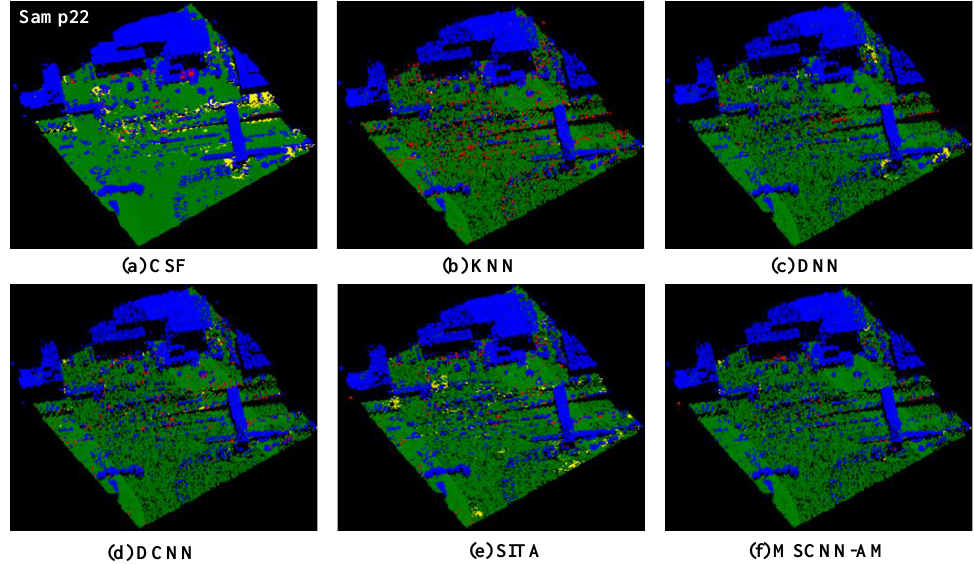
Figure 11. The filtering results of six methods on Samp22. ( a ) CSF; ( b ) KNN; ( c ) DNN; ( d ) DCNN; ( e ) SITA; ( f ) MSCNN-AM.